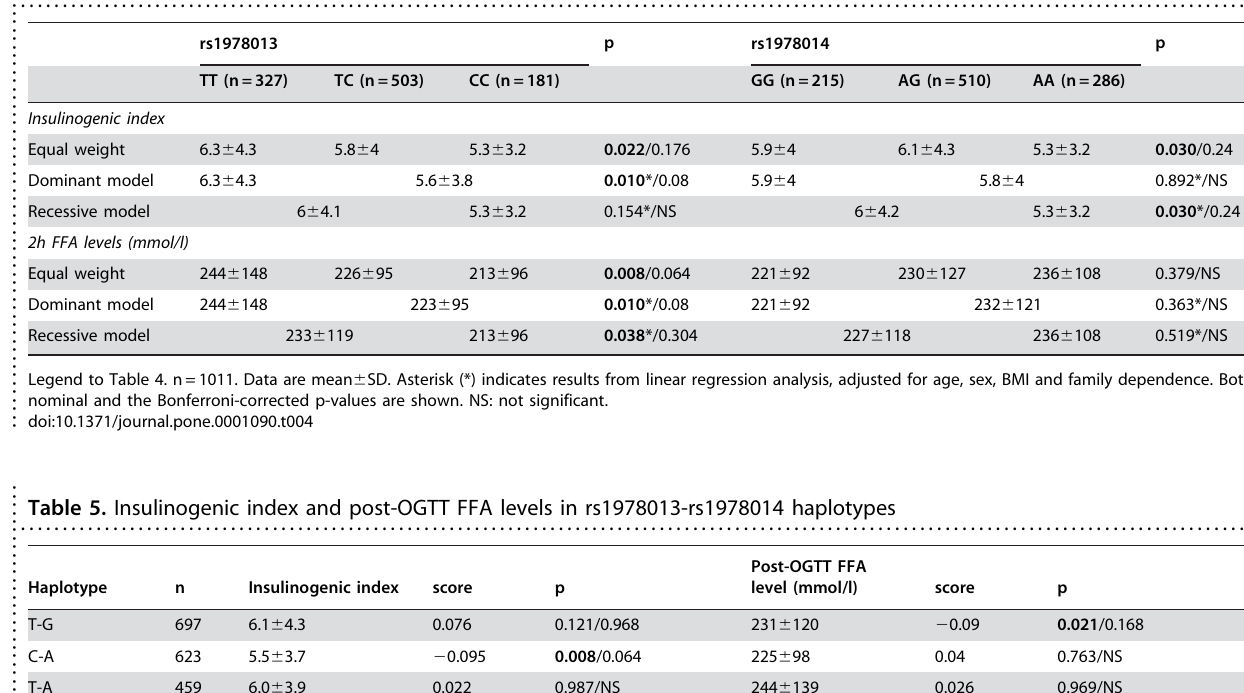
Table 4. Insulinogenic index and post-OGTT FFA levels in different genotype carriers .. ... .... ... ... .... ... ... .... ... ... .... ... ... .... ... ... .... ... ... .... ... ... .... ... ... .... ... ... .... ... ... .... ... ... .... ... ... .... ... ... .... ... ... .